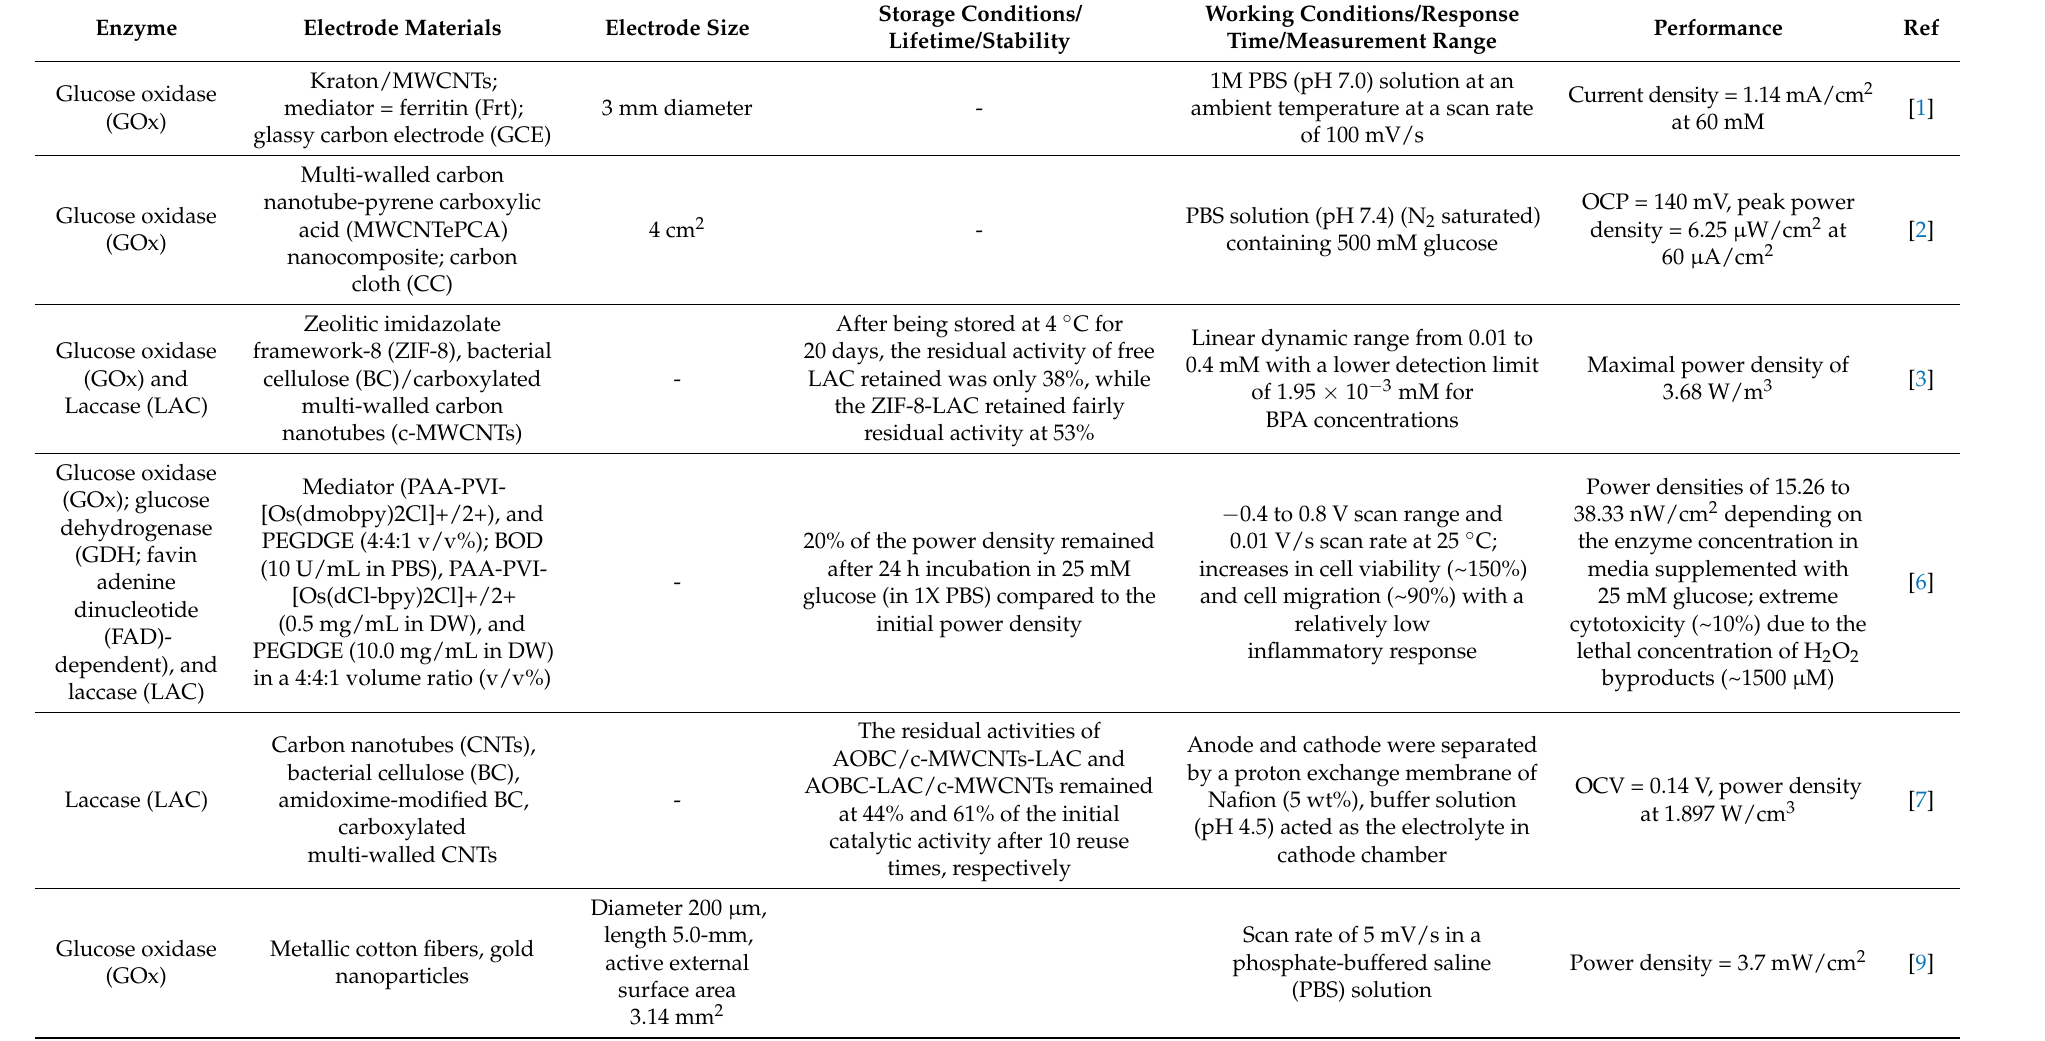
Table 1. Summarized development of the electrode materials in